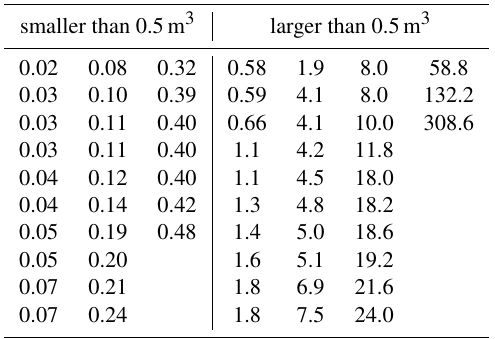
Table 1. Volumes of the surveyed blocks in the deposition area of the Buisson site. The blocks are divided into two classes, depending on their size (smaller or larger than V t ). All the blocks belong to list F ; blocks larger than V t belong to the reduced list F ∗ .